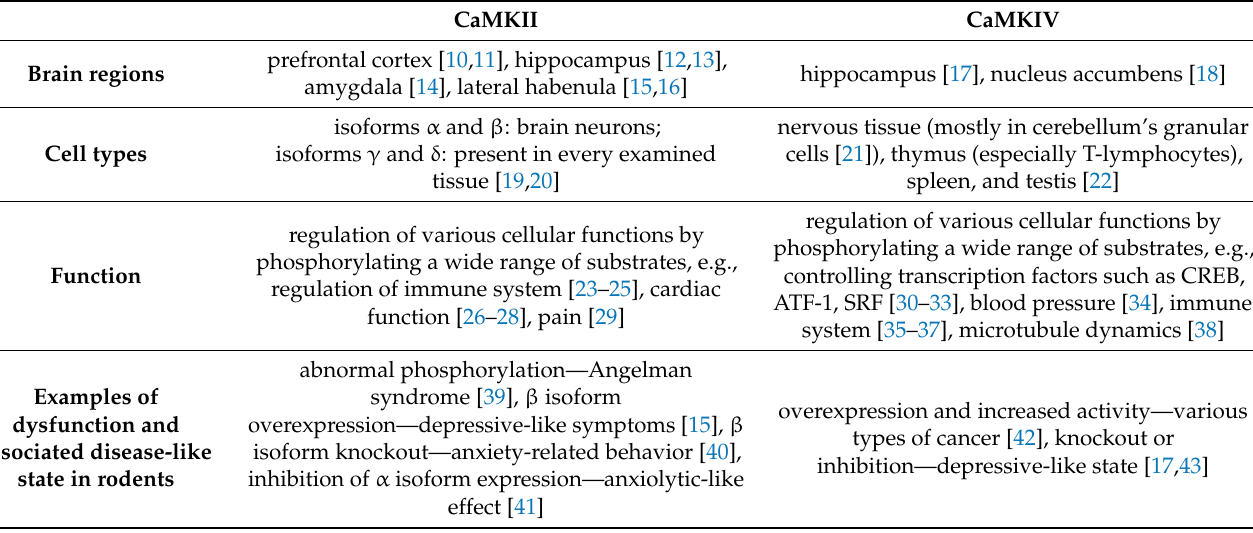
Table 1. Comparison of calcium/calmodulin-dependent kinases (CaMK) II and IV, considering brain regions, cell types, functions, and disease-like states in rodents associated with dysfunctions of